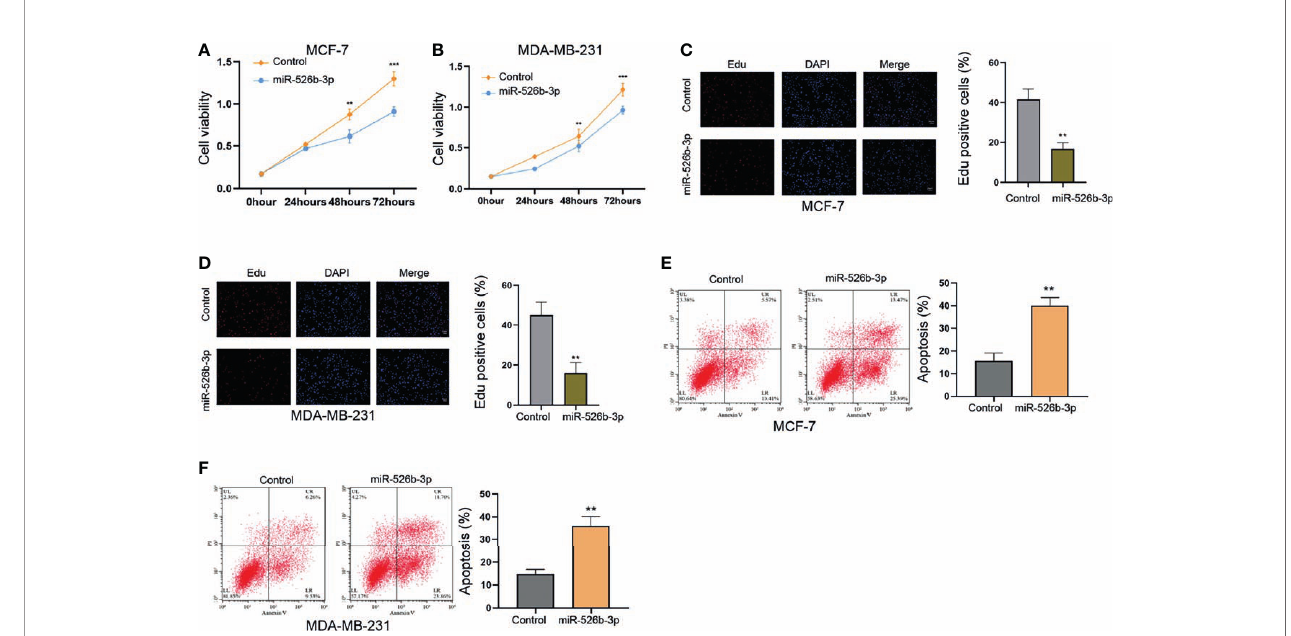
FIGURE 1 | MiR-526b-3p suppresses proliferation and enhances apoptosis of breast cells in vitro. (A – F) The MCF-7 and MDA-MB-231 cells were transfected with miR-526b-3p mimic. (A, B) Viability of MCF-7 and MDA-MB-231 cells was detected by CCK-8 analysis. (C, D) Proliferation of MCF-7 and MDA-MB-231 cells was analyzed by Edu analysis. (E, F) Apoptosis of MCF-7 and MDA-MB-231 cells was determined by fl ow cytometry analysis. Data are mean ± SD: ** p < 0.01, *** p < 0.001.